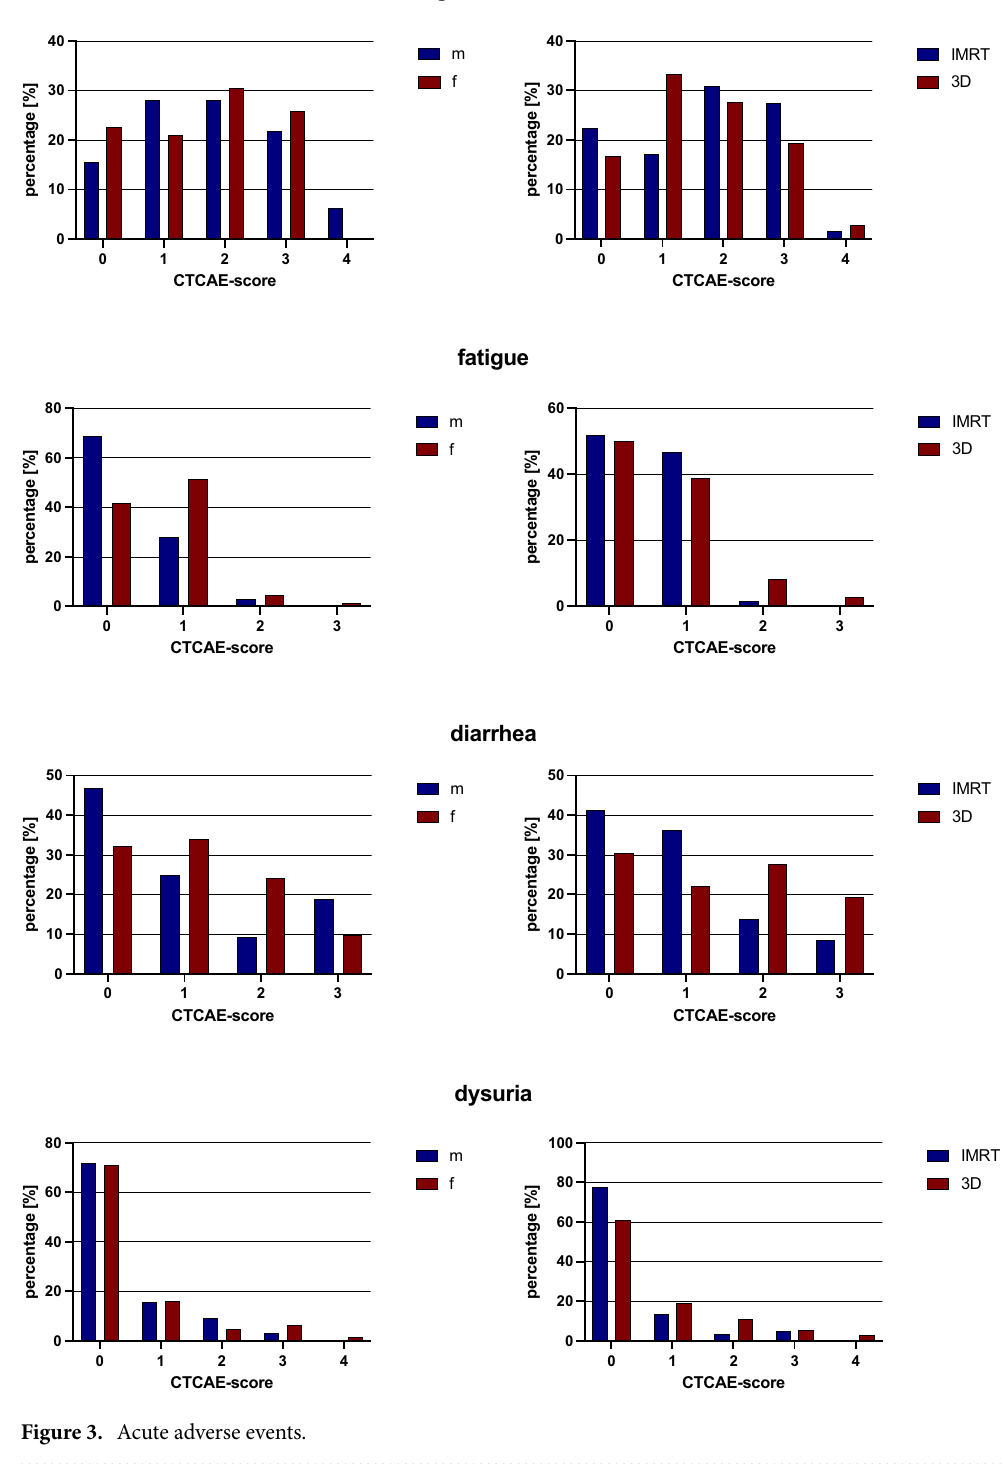
Figure 3. Acute adverse